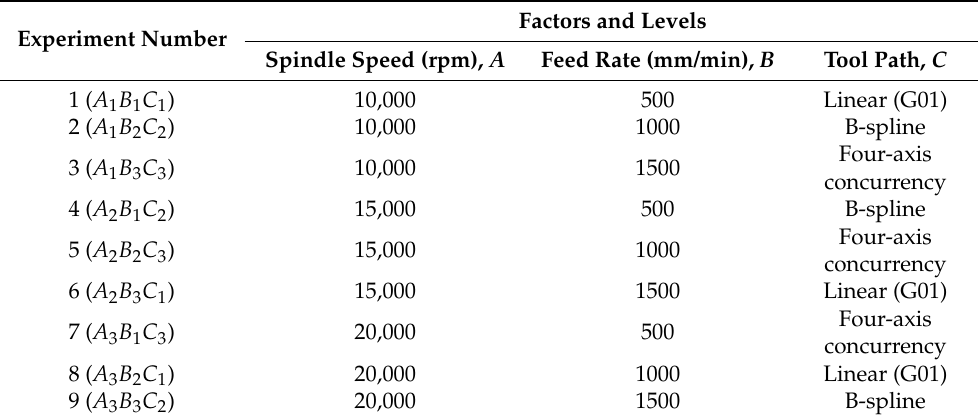
Table 8. Orthogonal array of the experimental factors and levels.